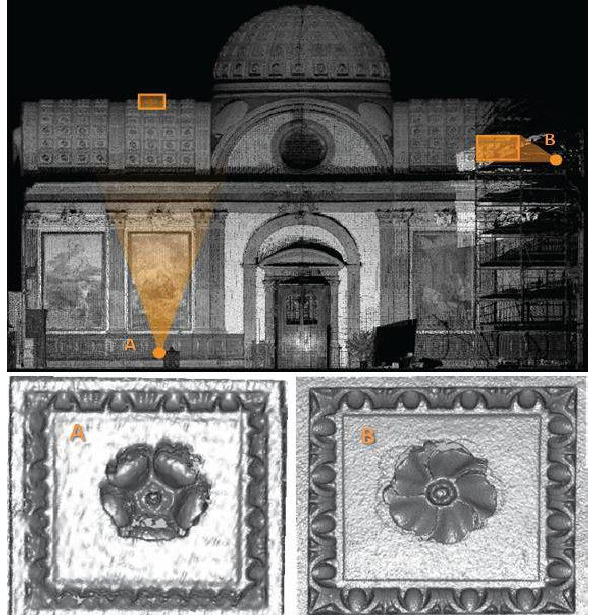
Figure 8. Pistoia, Basilica dell’Umilta (Laser scanner survey by GeCo Lab., 2008). Two different details have been acquired from different distances, setting the scan density in order to obtain almost the same number of points in both models: the surface model’s quality is affected by beam diameter, that increase with distance.